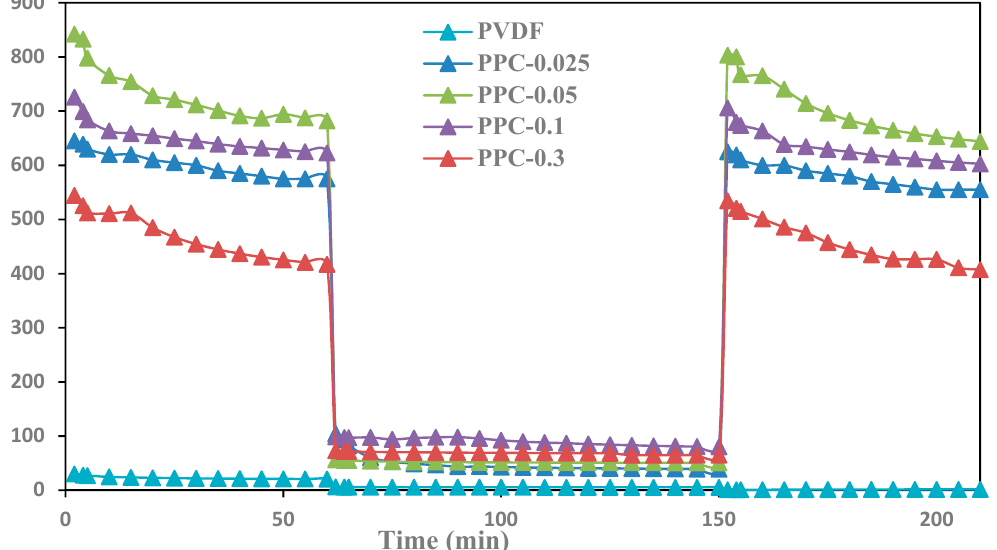
Figure 12. Fouling behavior and flux recovery for pristine and modified PVDF membrane: first one-hour for permeation with pure water, then rejection with crude oil, and finally, cleaning the membrane with 0.1M NaOH and one-hour permeation of pure water.